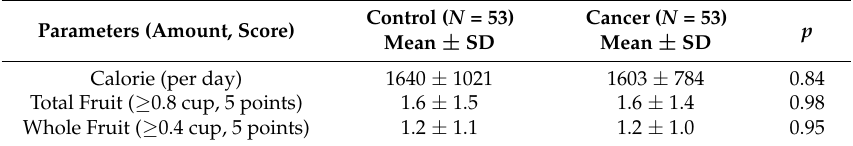
Table 2. Comparisons of dietary parameters in the Healthy Eating Index between the control and cancer